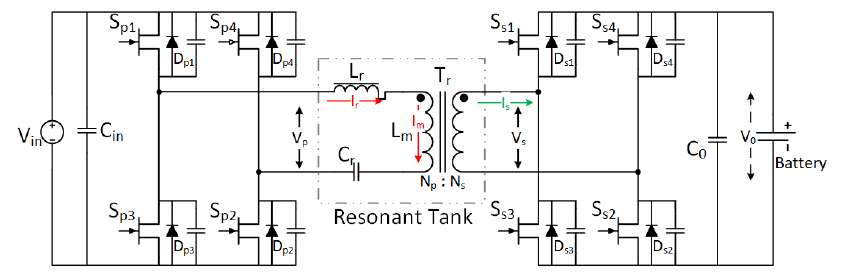
Figure 2. LLC resonant converter